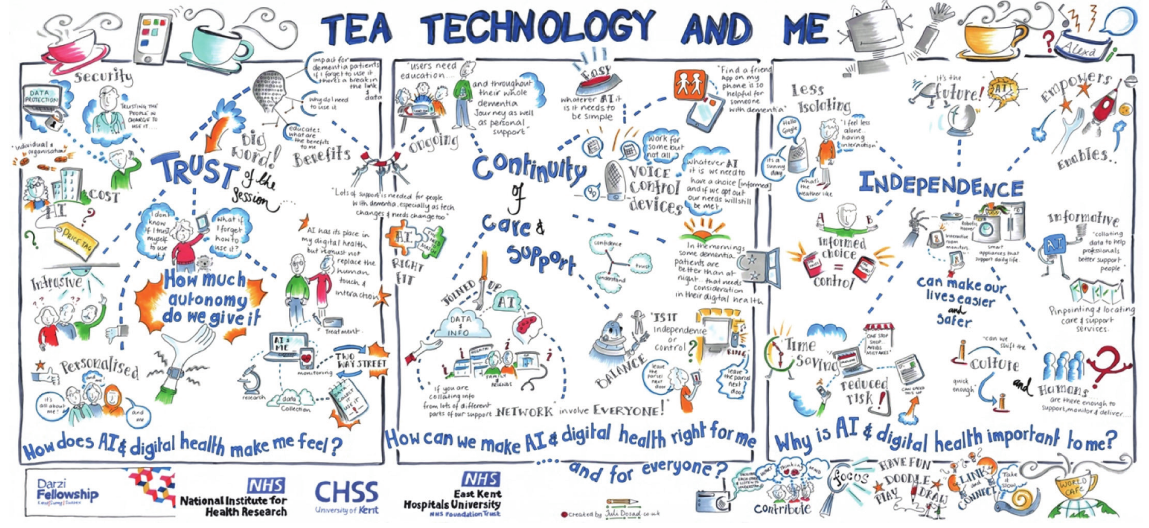
Figure 1. Tea, Technology and Me themes (Source: @ Juli